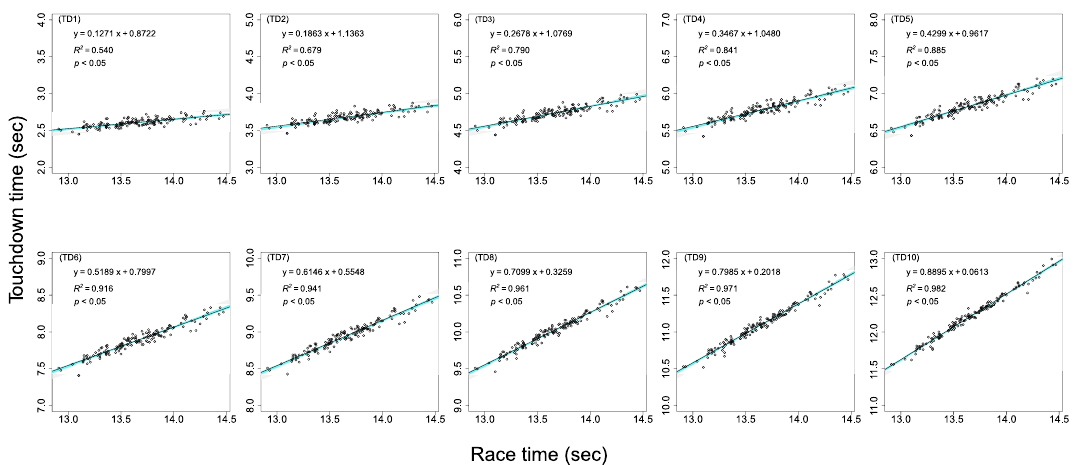
Fig 1. Relationships between the race time and each touchdown time (TD). Shaded areas in blue indicate the 95% confidence interval for regression lines. Shaded areas in gray indicate the 95% prediction interval for estimated touchdown times.